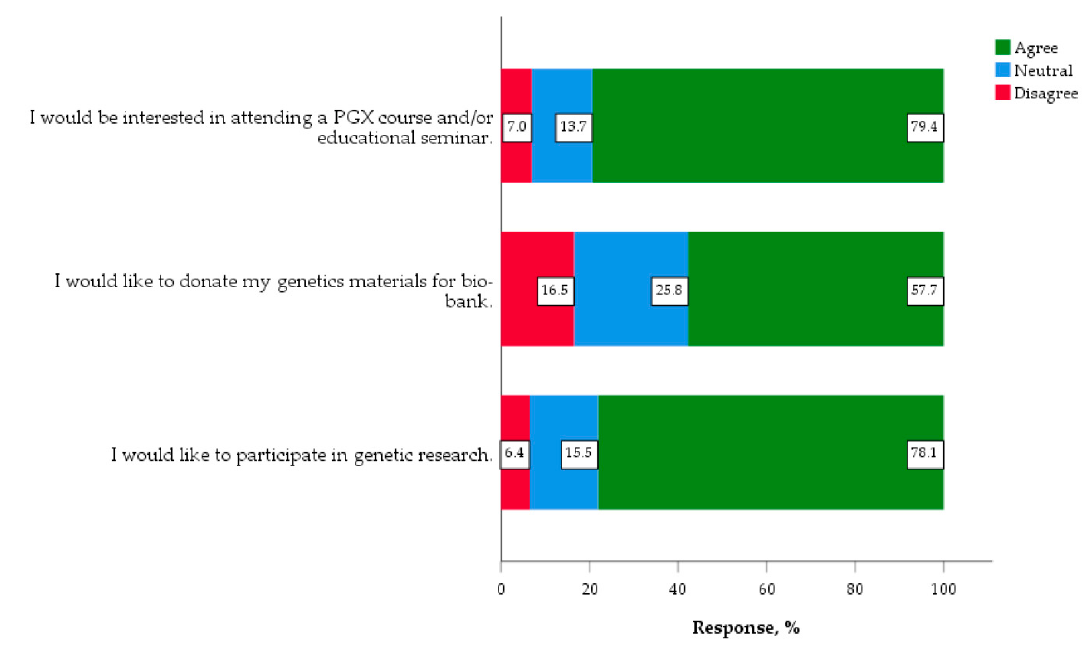
Figure 2. Desire to participate in genetic and PGX research ( n = 388).